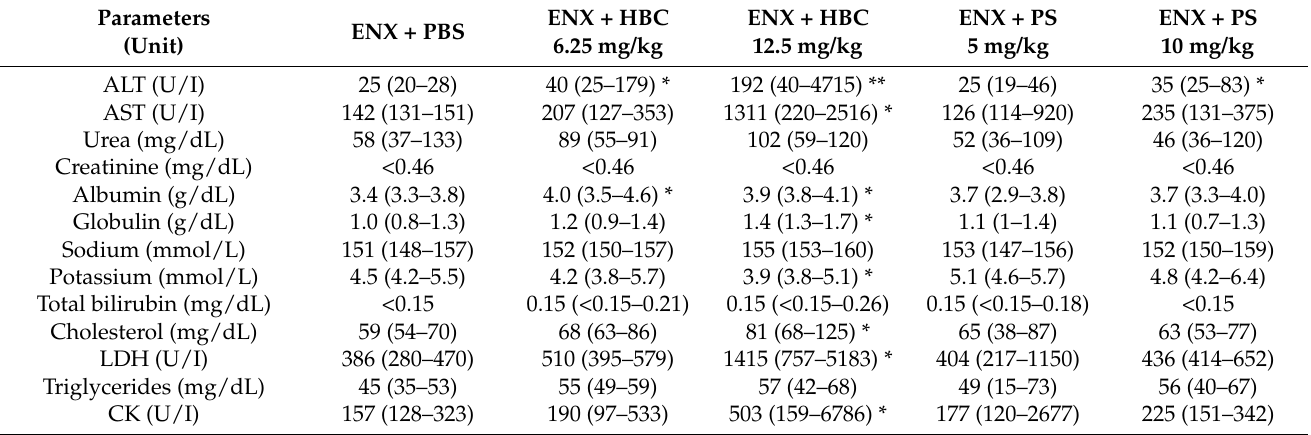
Table 2. The analysis of biochemical parameters of mice treated subcutaneously with enoxaparin (ENX) (5 mg/kg), and an intravenous bolus of vehicle, HBC (6.25 and 12.5 mg/kg), or protamine sulfate (PS) (5 and 10 mg/kg). The blood for biochemical parameters was drawn from the heart 10 h after the administration of